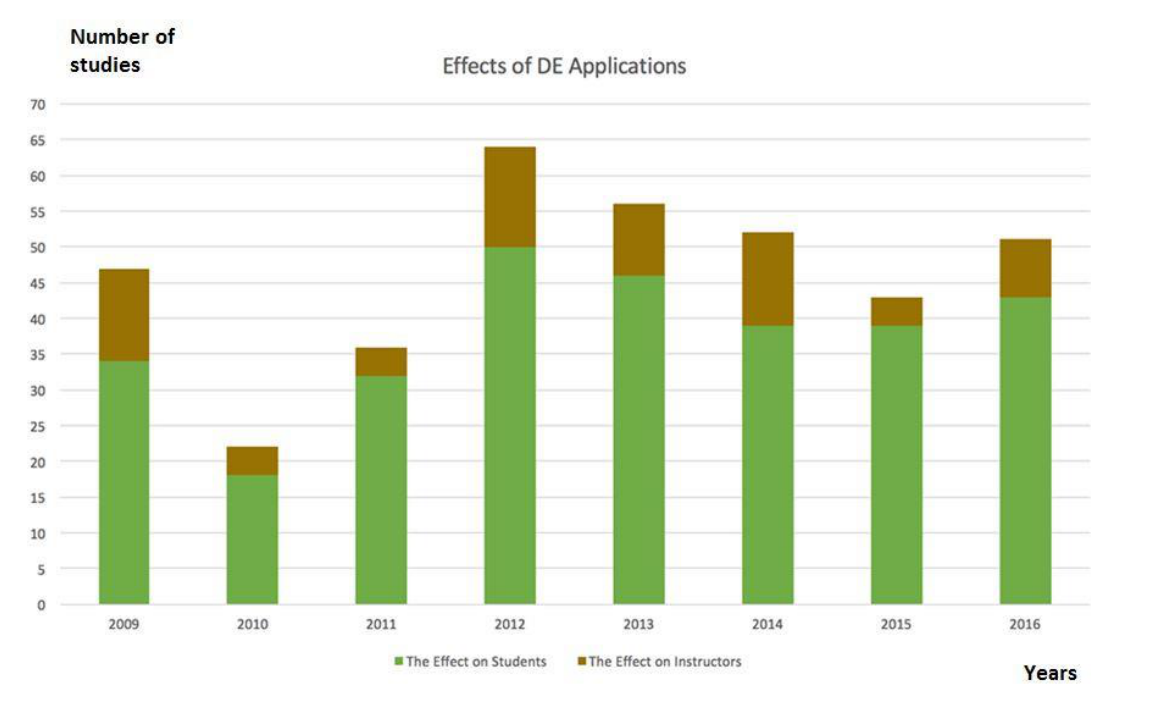
Figure 6. Trends in the main theme of Instructional Design Process in DE.